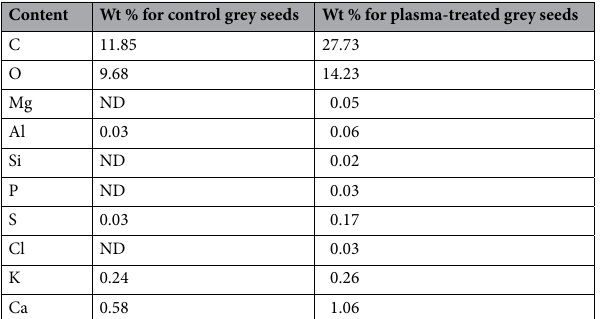
Table 2. EDX analysis of control and plasma treated grey seeds. ND not